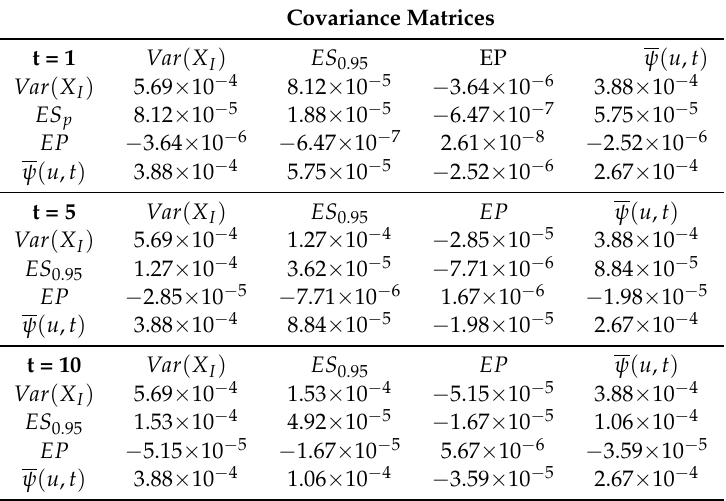
Table 7. Covariance matrices of normalized attributes for t = 1, 5, 10 when u =